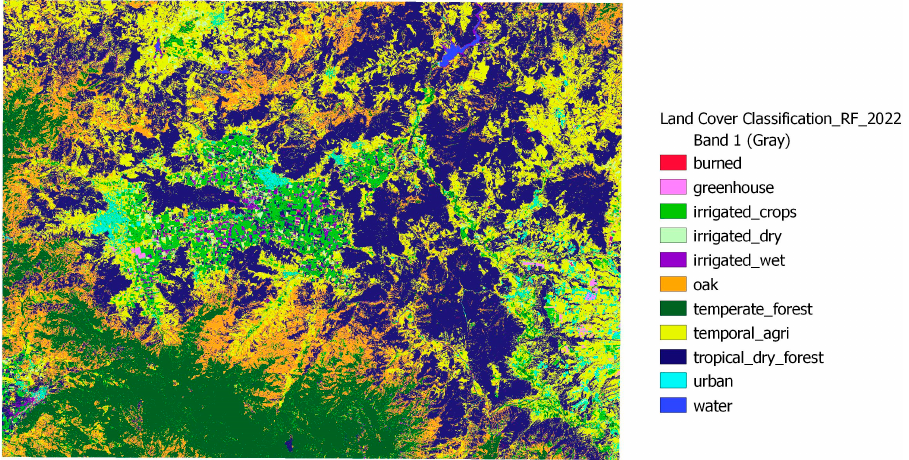
Figure A6. Land cover classification using random forest (RF) for 2022. Irrigated crops is short for Irrigated agriculture with crops; Irrigated dry is short for Irrigated agriculture without crops (dry); Irrigated wet is short for Irrigated agriculture without crops (wet); Temporal agriculture is short for Temporal agriculture with pasture; Oak is short for Oak